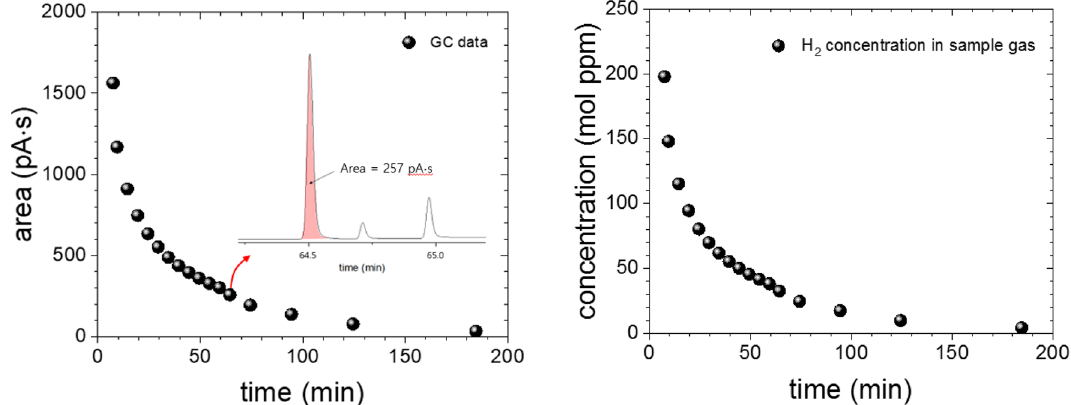
Figure 5. (Left) GC signal area versus the elapsed time after decompression. Inset is a set of GC spectra (peaks left to right: H 2 , O 2 , N 2 ) measured for the injection at the time 63 min. The peaks for O 2 and N 2 are due to the air remaining inside quartz tube. The peaks corresponding about 2–3 ppm are eliminated through purge process with helium gas. (Right) H 2 molar concentration converted from the GC raw data.